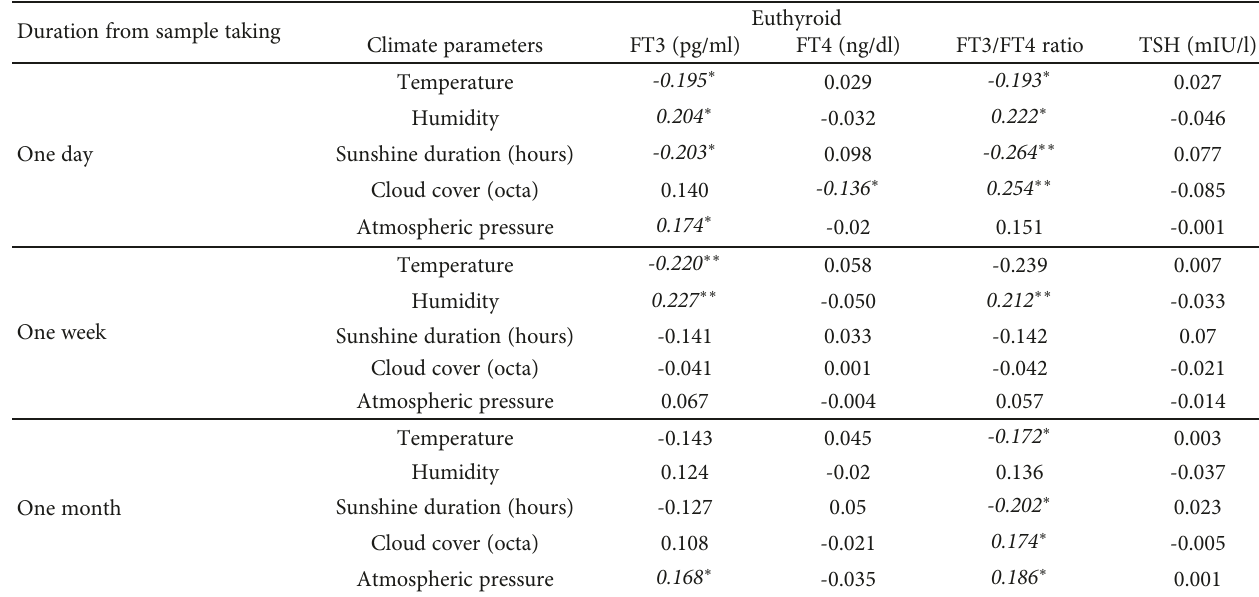
Table 5: Correlations of climate parameters of one day, one week, and one month before blood sample collection with the mean TSH, FT3, FT4, and FT3/FT4